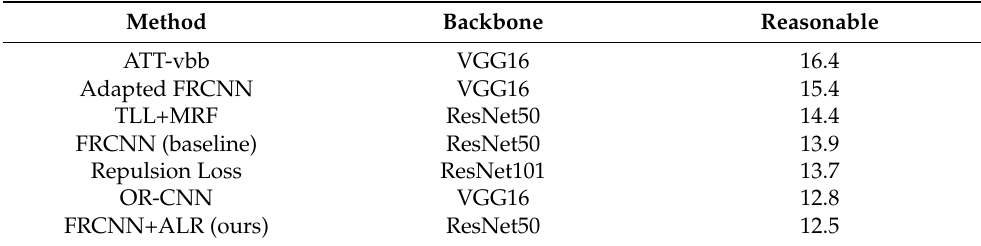
Table 7. Comparisons of the proposed FRCNN+ALR framework with other methods on the valida- tion set of the CityPersons dataset (MR − 2